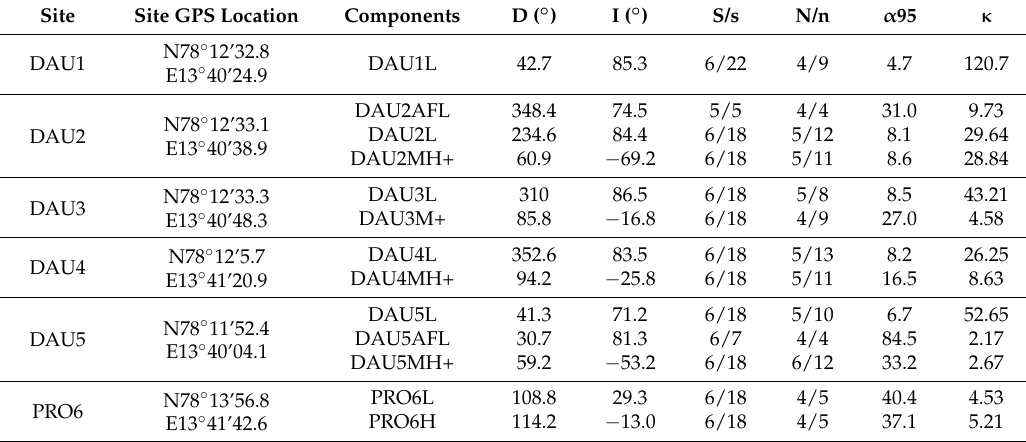
Table 2. Statistical parameters of the palaeomagnetic components identified in metadolerite samples of SW Oscar II Land. Components characterized by α 95 > 90° are not shown in the table. Explanations: L component < 250 °C; M component 250–350 °C; H component > 350 °C; AFL component < 20 mT; AFH component > 20 mT; + components calculated using “anchored” line fit method [46]; D—